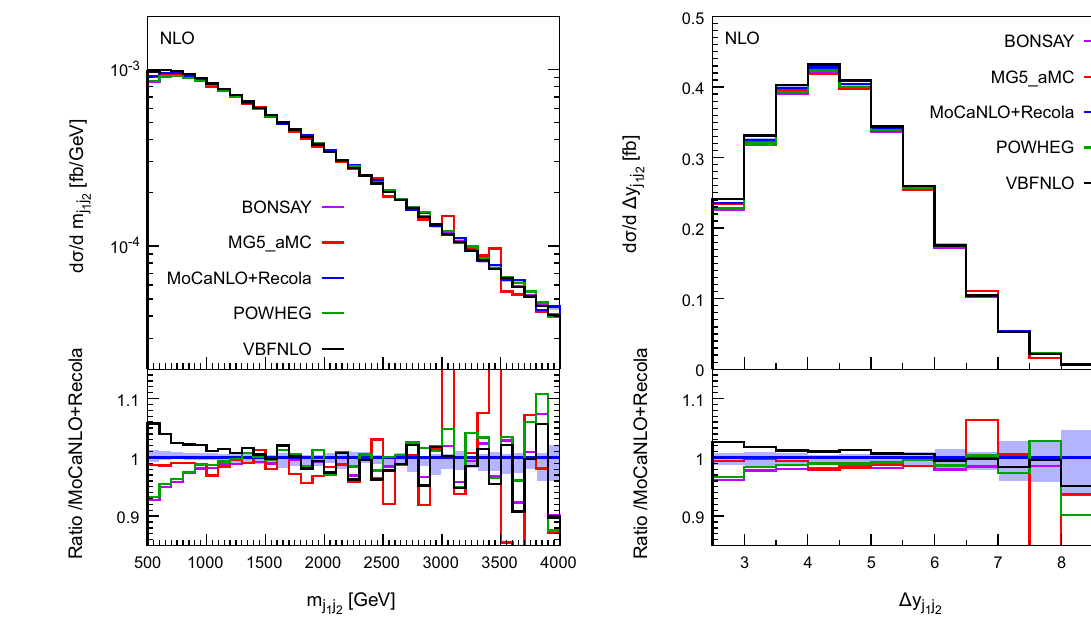
to MoCaNLO + Recola which is the full prediction. The band corre- sponds to a seven-point variation of the renormalisation and factorisa- tion scales. The predictions are obtained in the fiducial region described in Sect. 3.3